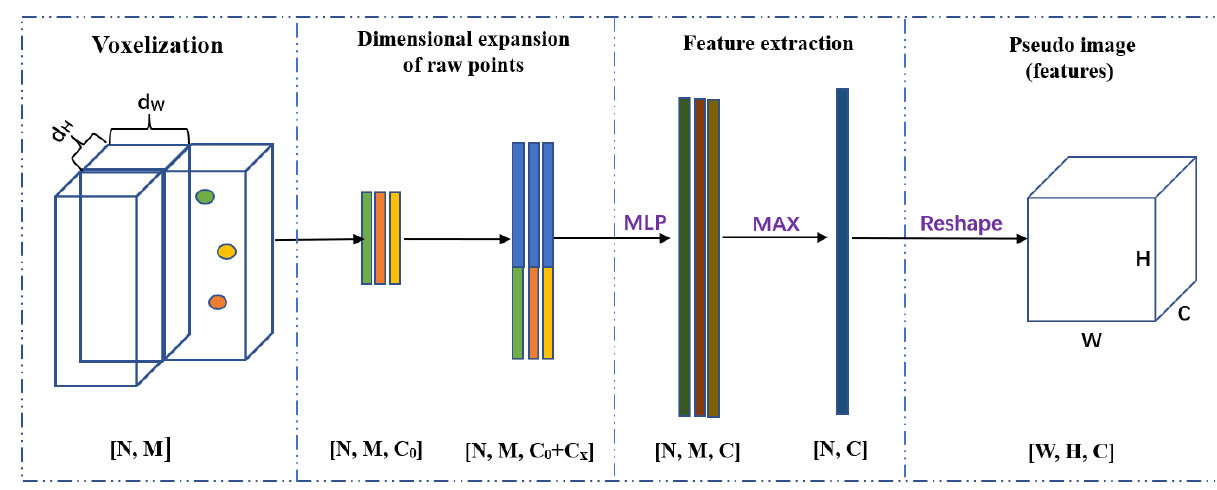
Figure 3. The overall process of grid-based point cloud encoder.